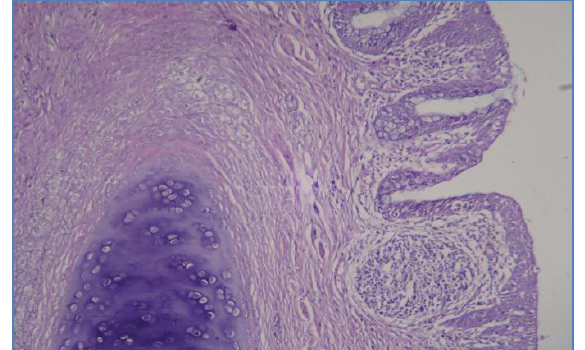
Figure, 6: Control larynx shows normal tissue, 72 hrs. post infection (H and E)